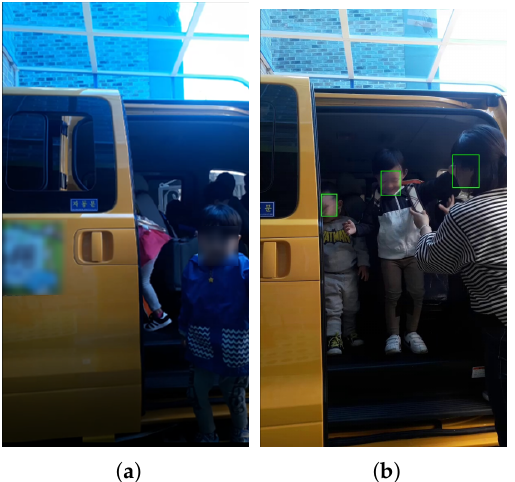
Figure 7. Images taken with a camera installed at door 2 (Figure 4d): ( a ) example; ( b ) recognition